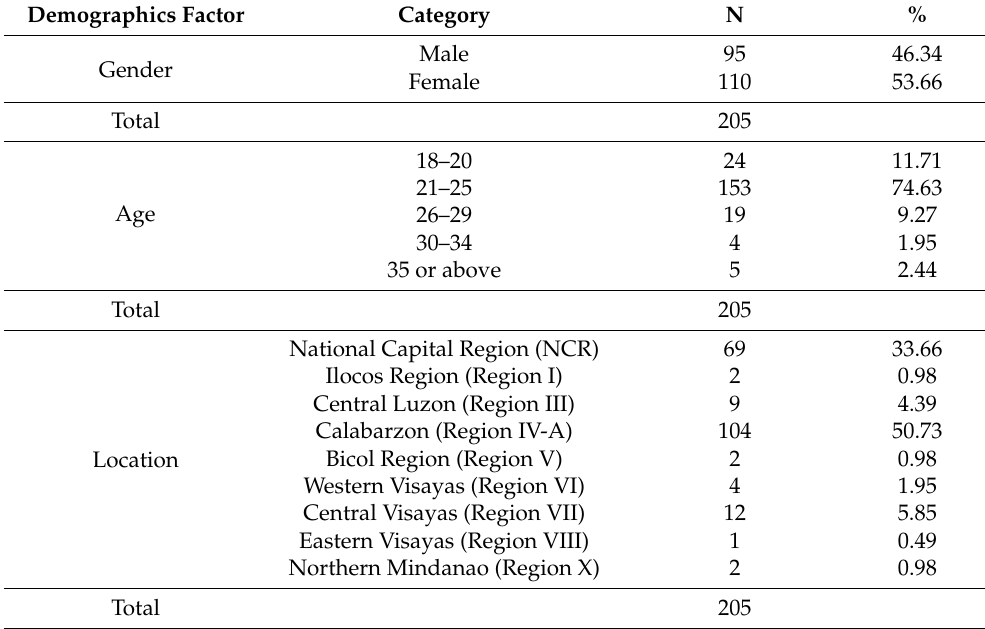
Table 3. Demographic